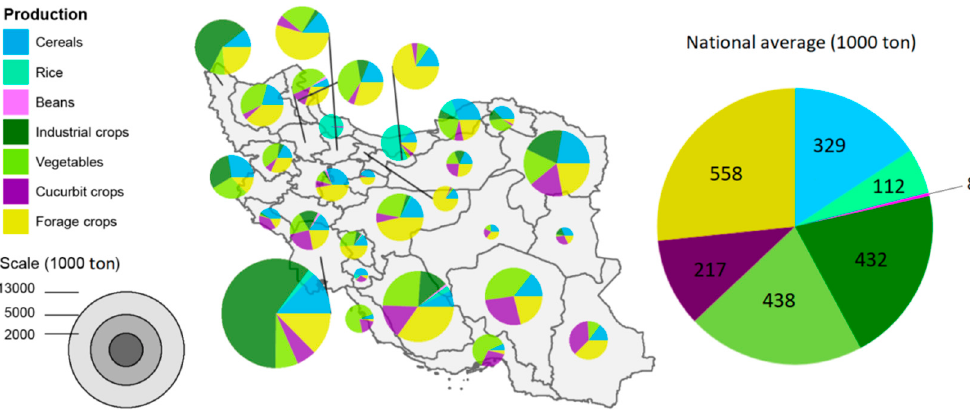
Figure 3. Agronomic production of seven crop categories in Iran in 2015 (Sources of data: Ahmadi et al. [33,34]).